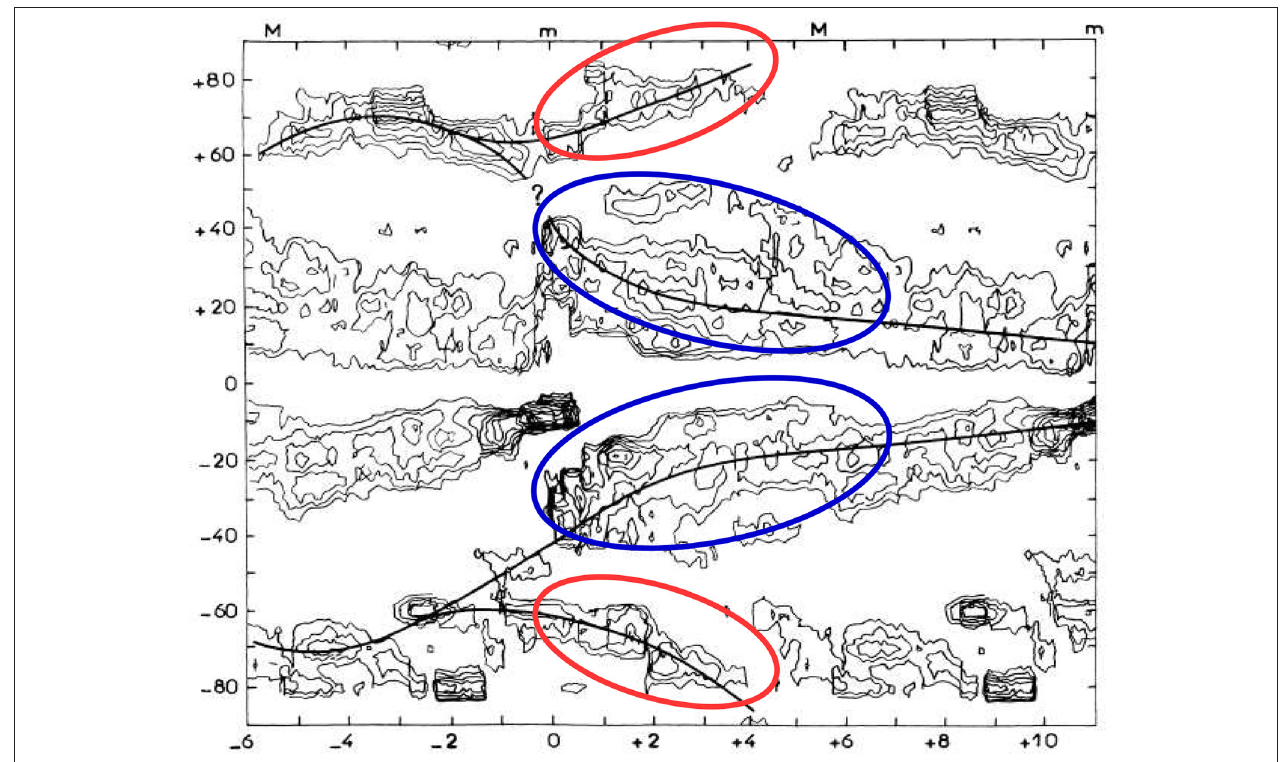
FIGURE 2 | The latitudinal of coronal emission and morphology obtained from Pic du Midi Observatory from 1944 to 1974 compared across cycles by aligning minima “m” and maxima “M” across the cycles in a form of superposed epoch analysis. Leroy and Noens (1983) noted that the pattern of coronal activity had an apparent (recurrent) period of about 17 years [Credit: Leroy et al., 1983, reproduced with permission (c)